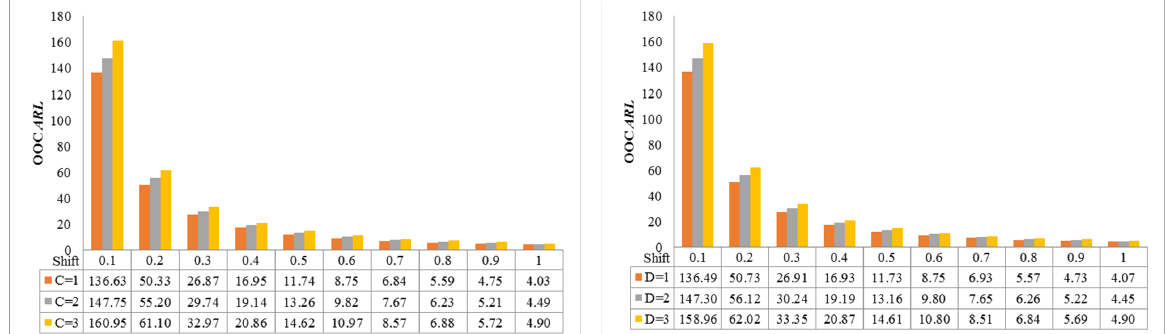
Fig. 5. The 𝐴𝑅𝐿 profiles of the HWMA 𝑋(cid:3364) ∗ scheme (for the mixed-3&4 strategy) with a linearly increasing variance when 𝐶 =0, 𝐷 ∈ {1,2,3}, 𝑛 =5, 𝜆 =0.1, 𝜙 =0.75, 𝐿 ∗ =2.938 and =500 𝐴𝑅𝐿 (cid:2868)